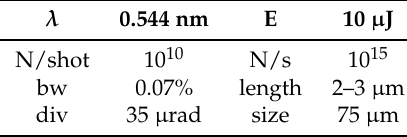
Figure 3. 5 × 5 cascade seeded by HHG: FEL radiation energy vs undulator position, temporal power distribution and spectrum (in the boxes) extracted at about 40 m. Seeded cascaded fresh-bunch case. First modulator (1st Mod) with 5 cm period. Second modulator (2nd Mod) with 2.8 cm period. Radiator with 1.2 cm period. The FEL simulations have been performed with GENESIS 1.3 [35]. Table 3. Radiation characteristics of the HHG seeded cascade. λ is the radiation wavelength, E the radiation energy, N/shot the numberof photons per shot, N/s the average number of photons, bw the relative r.m.s. bandwidth, div means divergence, length and size are the longitudinal and transverse rms pulse dimensions. The repetition rate of the source is assumed to be 100 kHz.